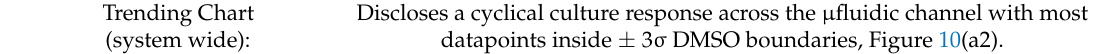
Table 6. Summary of LDH indicator